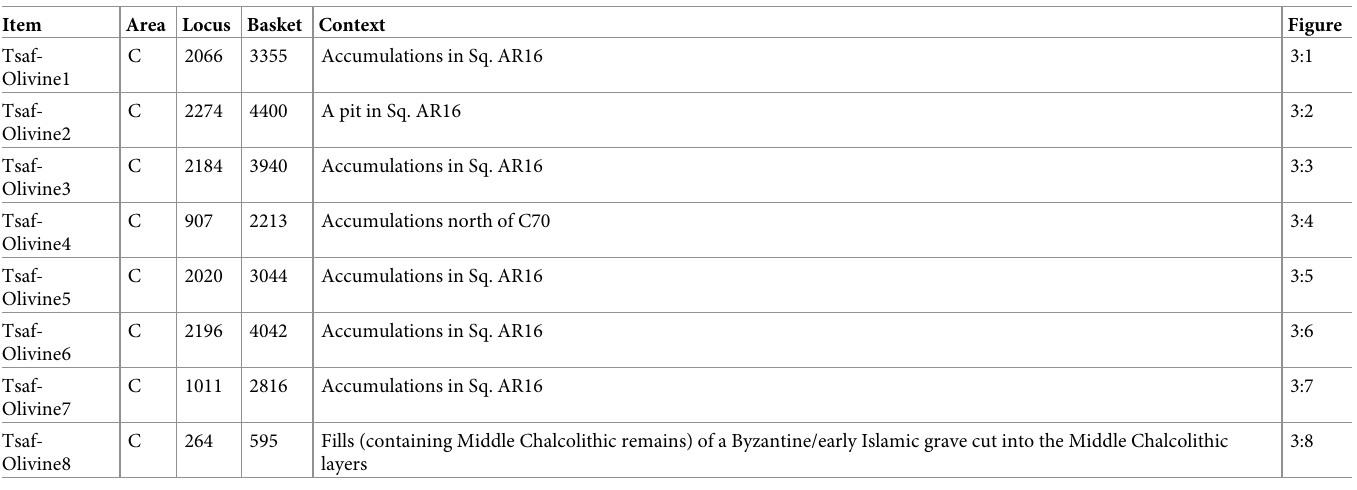
Table 1. The context of the Tel Tsaf olivine